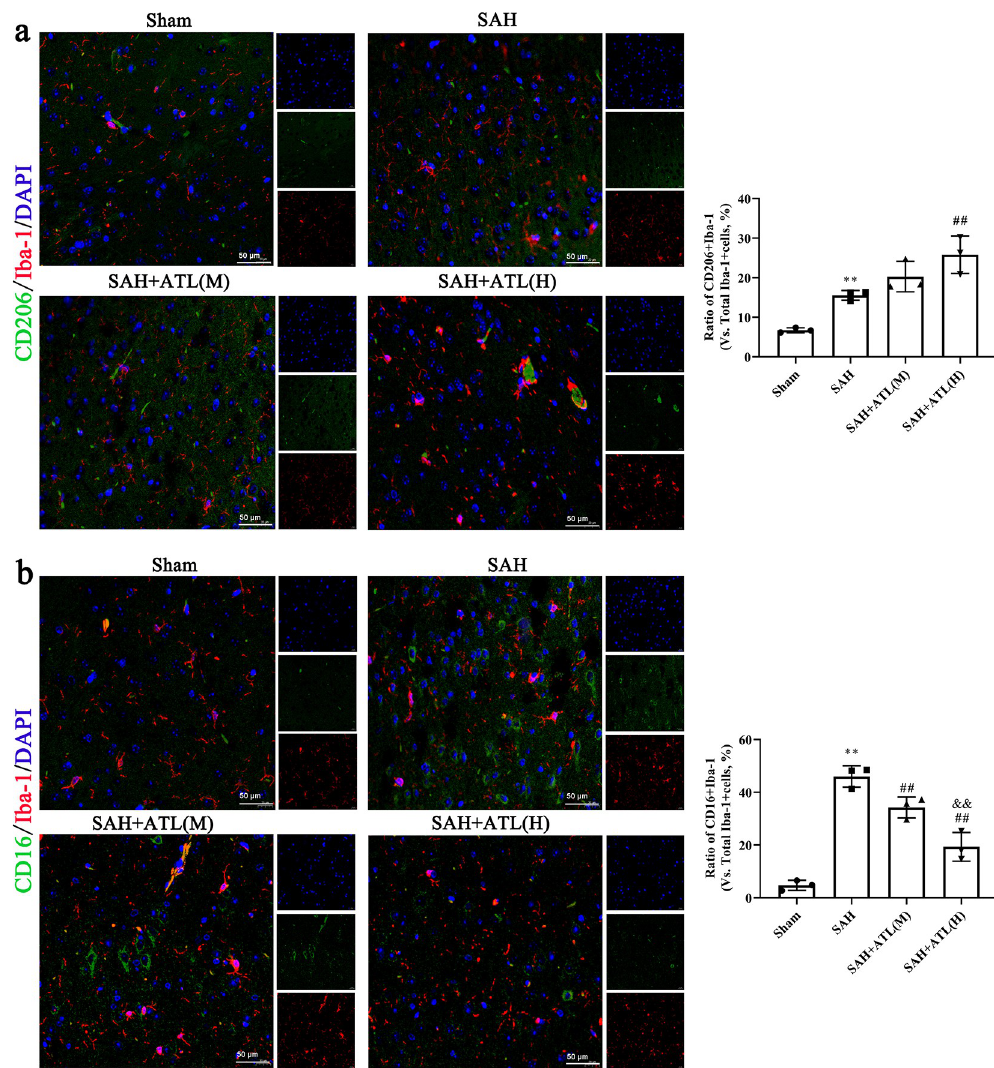
Fig 5. Effects of ATL on microglia polarization at 72h after SAH. (a) immunofluorescent staining against CD206/Iba-1 of the ipsilateral temporal cortex at 72h after SAH. Scale bar = 20 μ m. (b) immunofluorescent staining against CD16/Iba-1of the ipsilateral temporal cortex at 72h after SAH. Scale bar = 20 μ m. Data are represented as the mean ± SD. �� p < 0.01 vs. sham group; ## p < 0.01 vs. SAH group; && p < 0.05. n = 3, the number of images